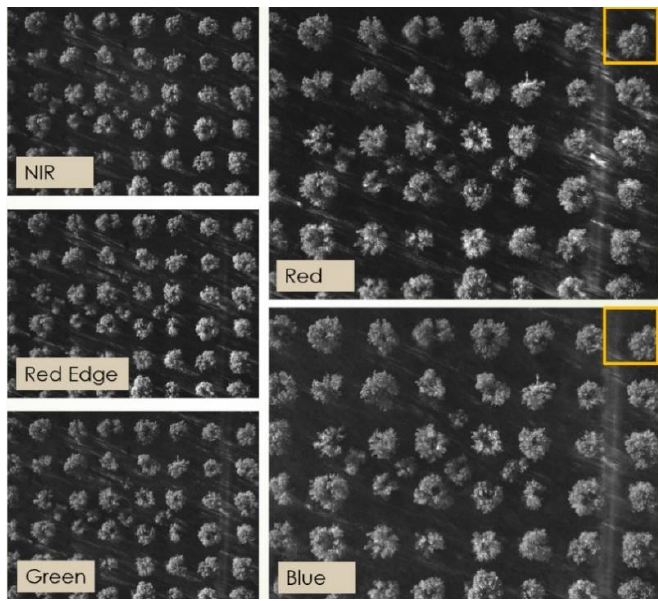
Figure 8. Example images of a multispectral stack. Each image is 960 pixels × 1280 pixels, corresponding to a ground size of about 64 m × 48 m.